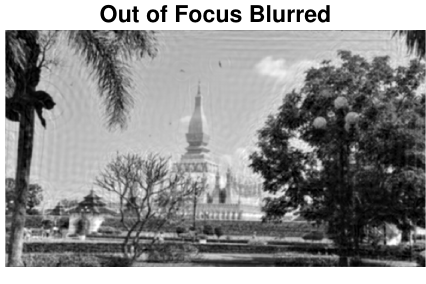
Figure 36. The reconstructed grey image of all cases using the proposed method (2) with PSNR = 24.